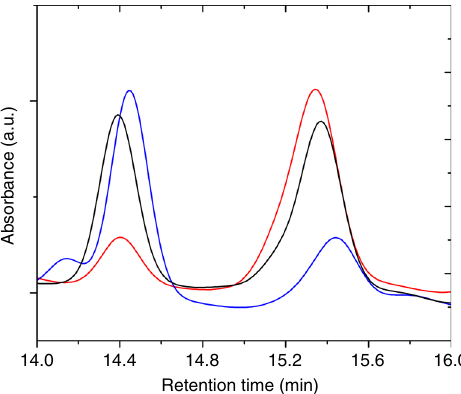
Fig. 6 Monitoring of enantioselectivity as a function of imprinted enantiomer. HPLC chromatograms of the electrosynthesis products obtained by an electrode imprinted with (S) -PE (red) and an electrode imprinted with (R) -PE (blue) (PE/PtCl 6 2 − weight ratio of 0.15). The respective signals are compared with a racemate of PE that is obtained by electrosynthesis with an electrode imprinted with racemic PE (black). Peaks at retention times of 14.4 and 15.3 min belong to (R) -PE and (S) -PE,